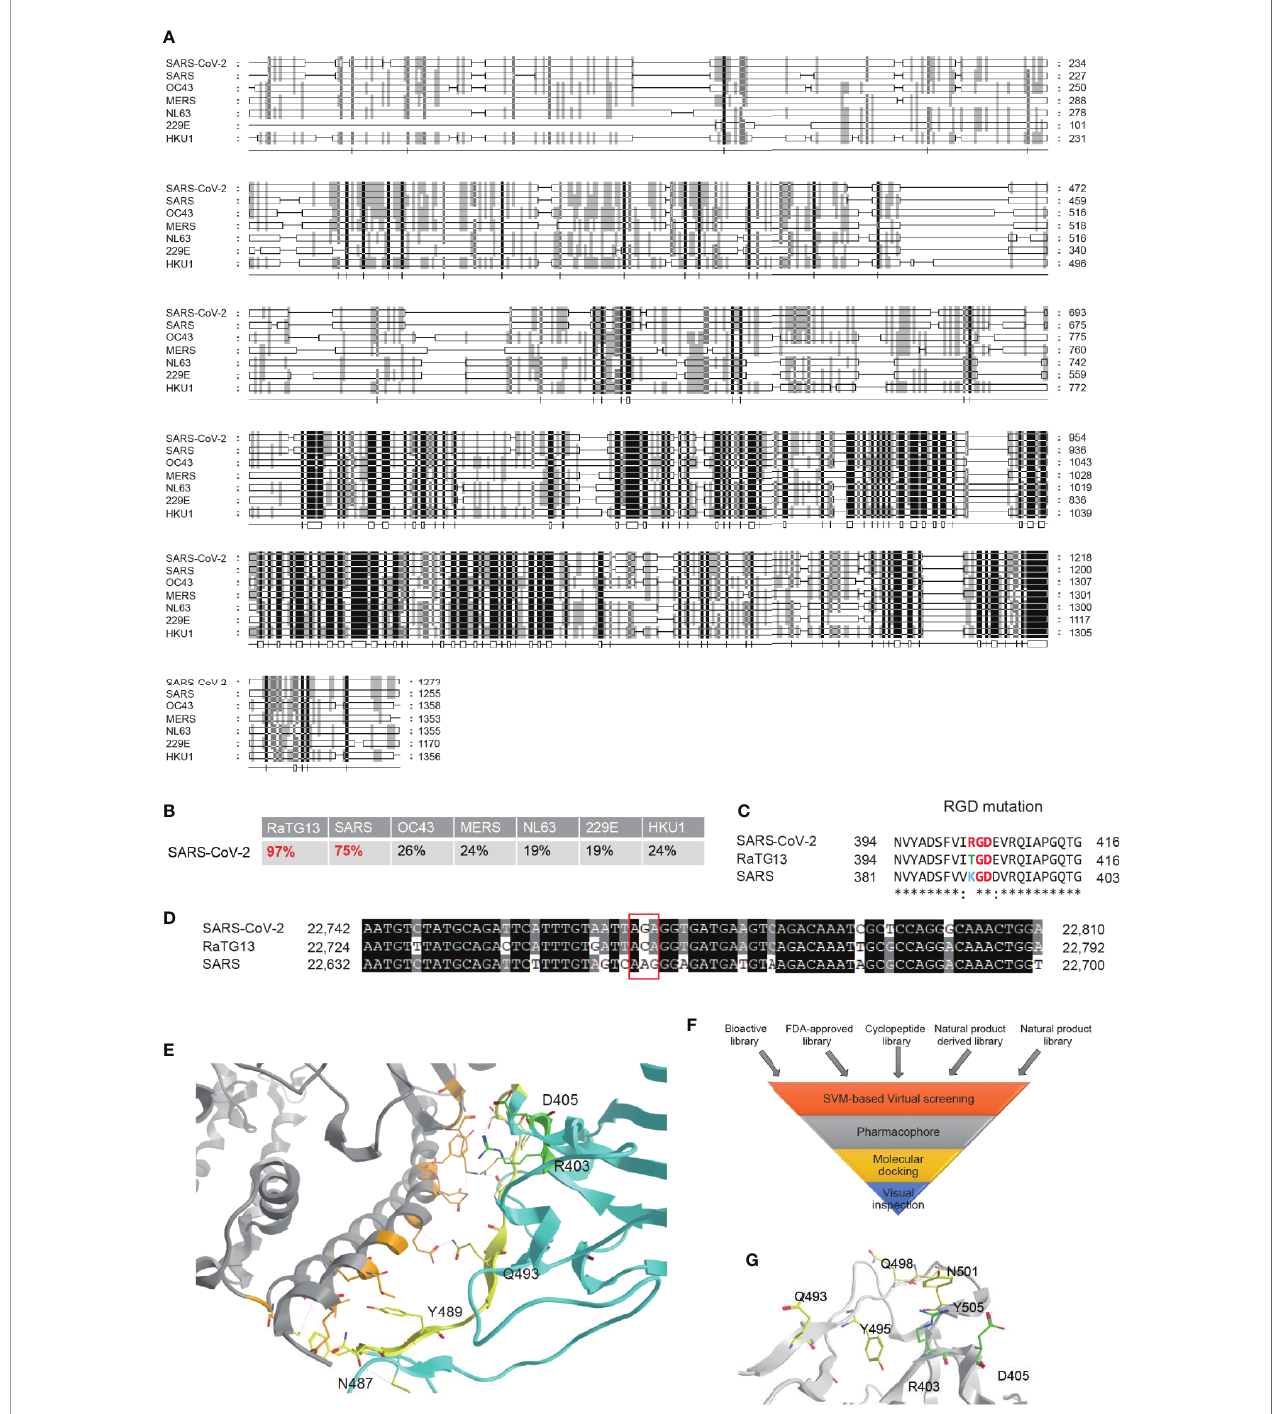
FIGURE 1 | Bioinformatics analysis of the S protein of the SARS-CoV-2 and identi fi cation of potential inhibitors for its interaction with ACE2. (A) Amino acid sequence alignment of the S proteins in the coronaviruses infecting humans, including SARS-CoV-2, SARS, OC43, MERS, NL63, 229E, and HKU1 strains. (B) Homology of SARS-CoV-2 to other coronaviruses based on the S protein alignment. RaTG13, a Bat-SARS-like coronavirus, is used as a control. (C) Evolution of the RGD motif in the S protein of SARS-CoV-2 compared with the S protein of SARS-CoV. (D) Nucleotide mutation produces RGD in SARS-CoV-2. (E) ACE2 binding interface regions of the S protein of SARS-CoV2. Location of the RGD motif was shown in green, and the yellow residues are the interaction surfaces binding with ACE2. (F) Flowchart of interaction surface structure-based virtual high-throughput screening. (G) The key residues in the S protein interface and the RGD motif were chosen as the potential binding site to generate the protomol for virtual screening by using Sur fl ex-Dock Geom (SFXC)